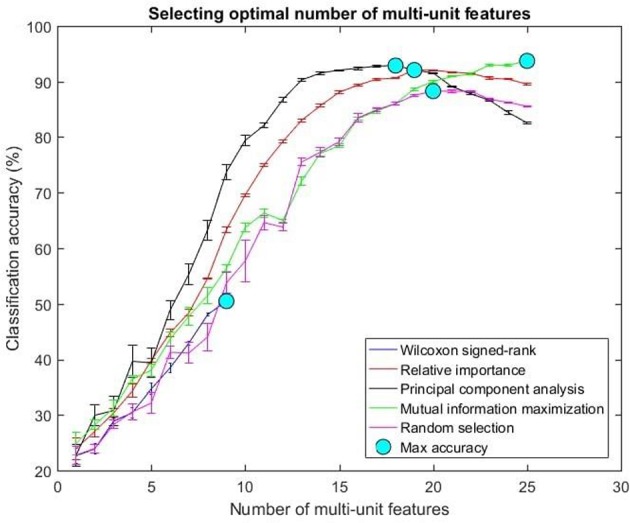
Selecting optimal number of multi-units. The plot above shows the cross validated accuracy of feature selection algorithms for increasing number of multi-unit features. The solid circle (cyan) in each graph shows the maximum cross-validated accuracy for a feature selection algorithm. The number of single or multi-unit features corresponding to this accuracy was chosen as the optimal number of features. The points and error bars correspond to the mean and standard error of maximum cross-validated accuracy respectively.